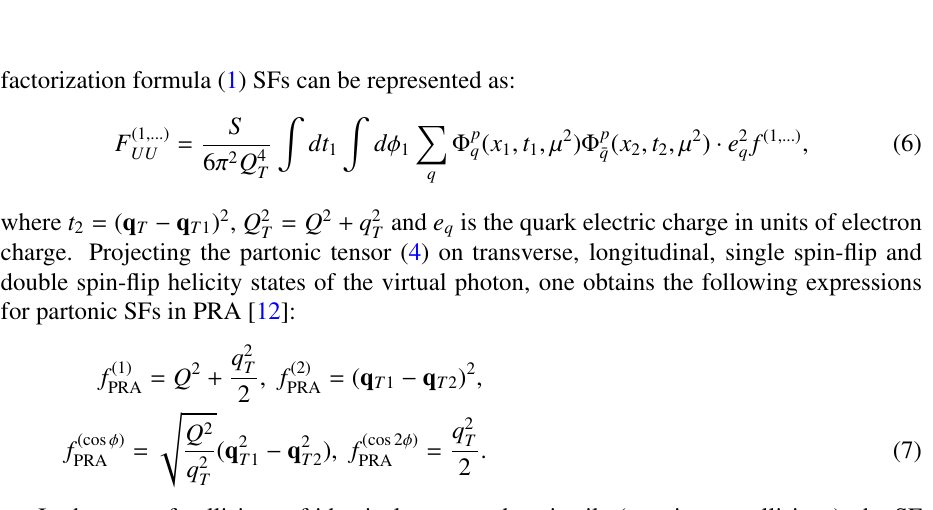
Figure 1. Feynman diagrams for the t -channel quark-antiquark annihilation subprocess (a), which leads to the usual parton-model picture, and direct interaction subprocesses (b,c) which are necessary to restore QED gauge invariance of diagram